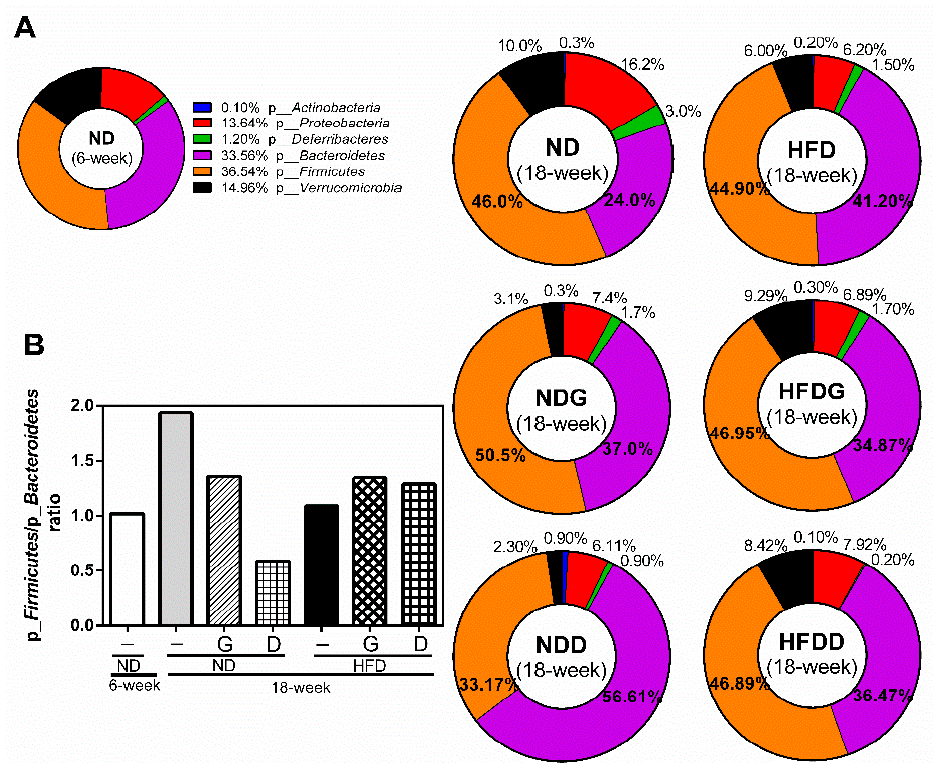
Figure 8. Modulation of the gut microbiome at the phylum level. The gut microbiota was characterized by 16S rRNA gene sequencing. ( A ) The relative abundance of bacteria at the phylum level. ( B ) The ratio of p_ Firmicutes to p_ Bacteroidetes based on their relative abundance.